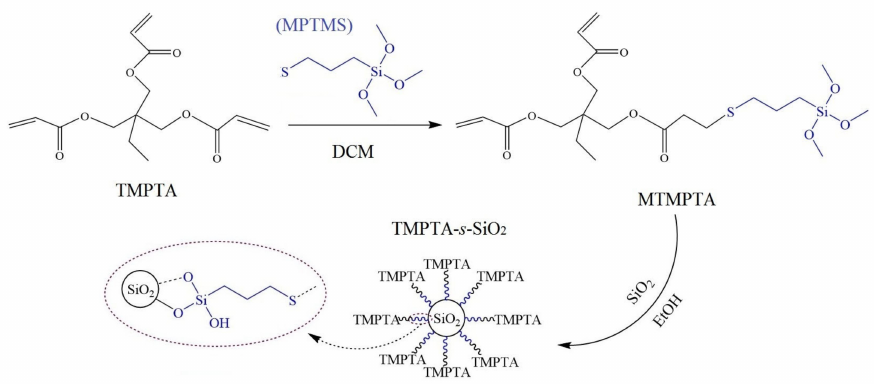
Figure 1. Schematicreactionsoftrimethylolpropanetriacrylate(TMPTA)graftingontothenanosilicasurface.